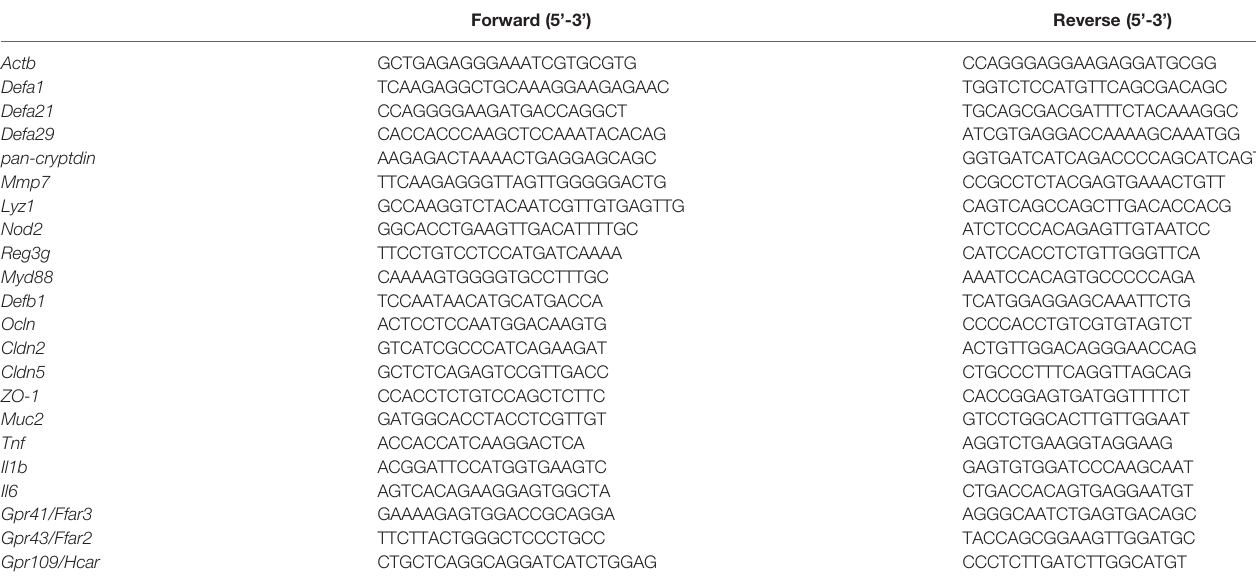
TABLE 1 | Primers used in quantitative real-time